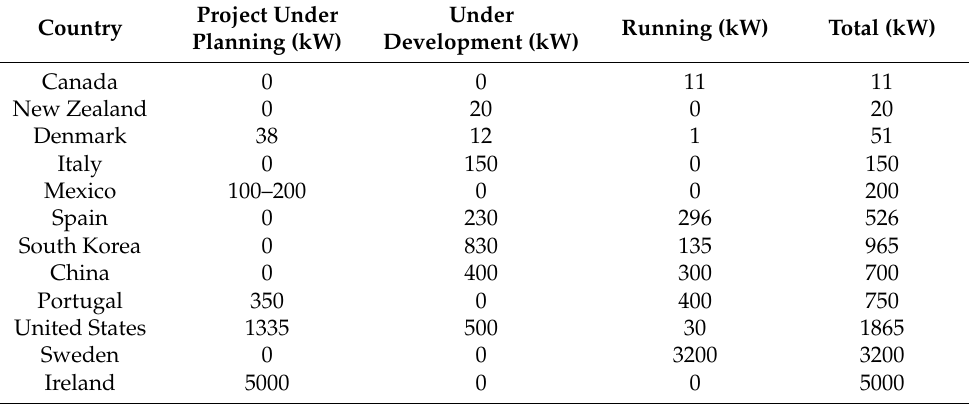
Table 1. The Installed Capacity of Wave Energy Converter All Over the World [42].